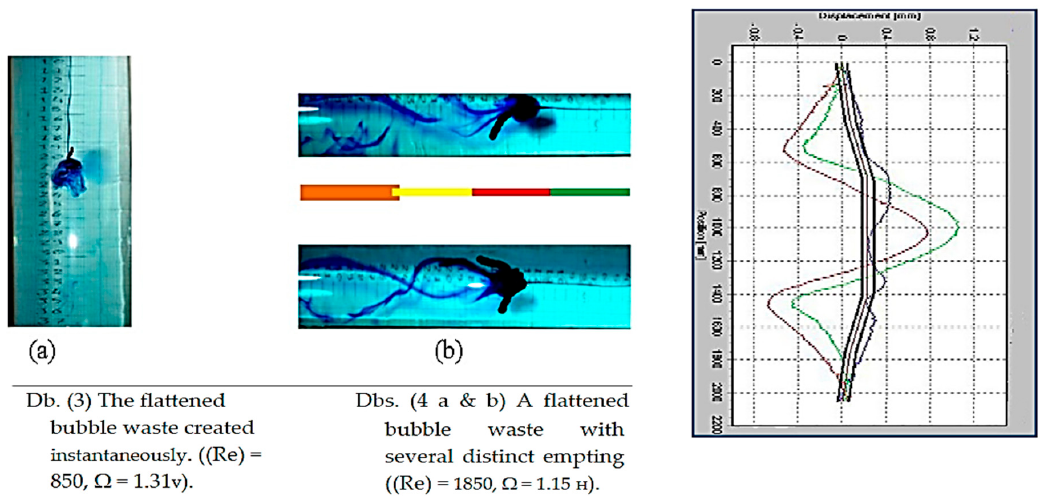
Figure 18. ( a ) Type 2, The Db (3) and the Db (4a & 4b) of Flattened bubble waste shape; ( b ) Type 2, Figure 18. Type 2, Flattened bubble waste. The Db (3) and the Db (4a & 4b) of Flattened bubble waste behavior.